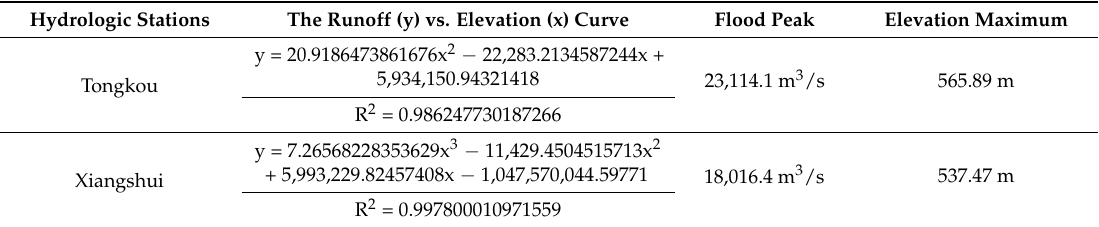
Table 8. Runoff versus elevation curve in Tongkou and Xiangshui.